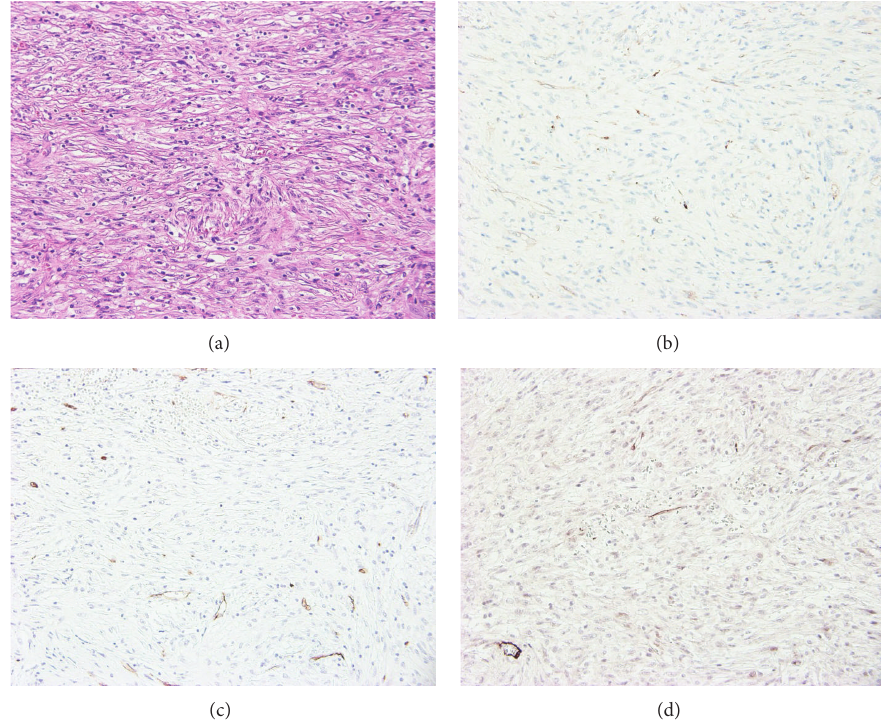
Figure 3: Microscopic photograph showing spindle-shaped cells with moderate cellularity crowded into bundles (hematoxylin and eosin stain, × 20) (a). Immunohistochemical studies reveal that tumor cells are positive for c-kit (b), CD34 (c), and 𝛼 -smooth muscle actin (d) ( × 20).